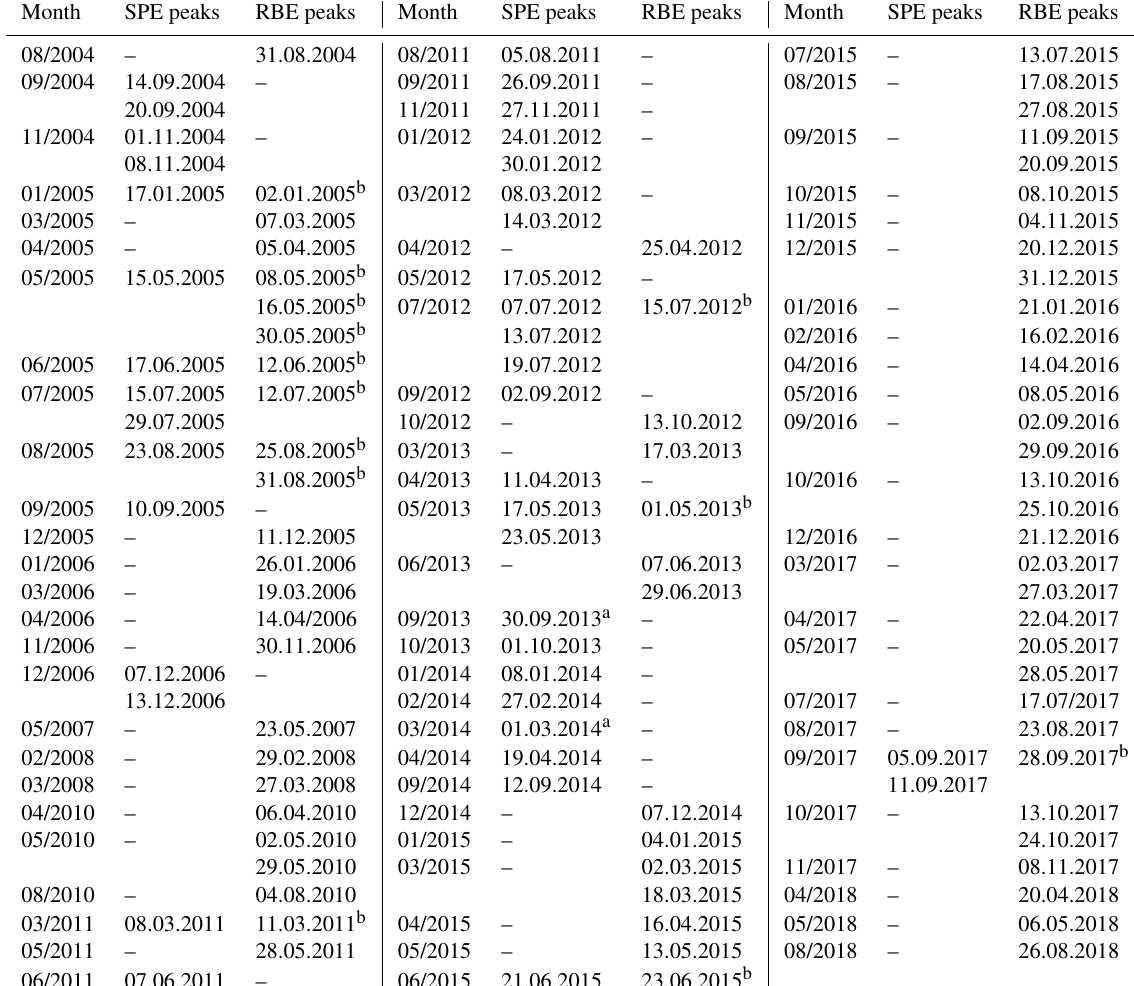
Table 1. Months included in the analysis, with dates (dd.mm.yyyy) of SPE and RBE flux peaks within each month (month/year) also given. For peaks within 5d of each other, only the date of the strongest is included. Dates marked by a indicate dates in months where the event peak was in another month. RBE peak dates marked by b are not included in the analysis, due to an SPE peak in the same